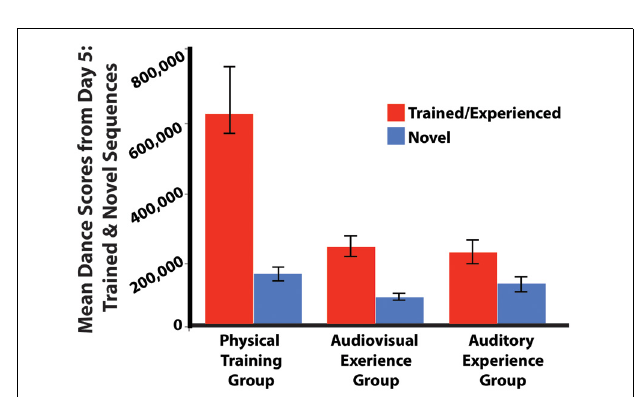
whilst physically performing the sequence [ F ( 1 . 15 , 23 . 04 ) = 1 . 740; p = 0 . 201; Figure 3B ]. As participants’ dance scores improved ( Figure 2 ), so did their subjective feelings of how well they know the sequences ( Figure 3A ).